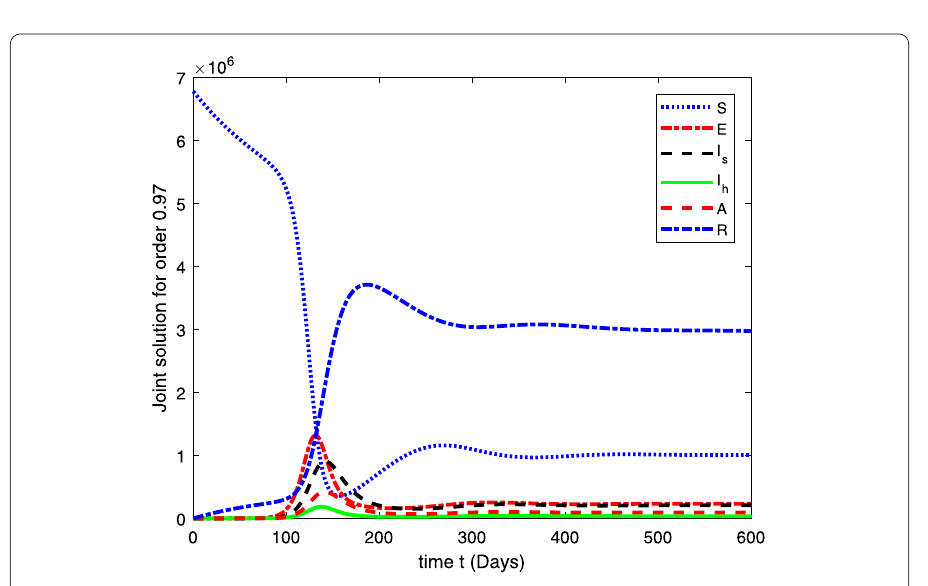
Figure 4 Joint solution of COVID 19 model (1) for the order